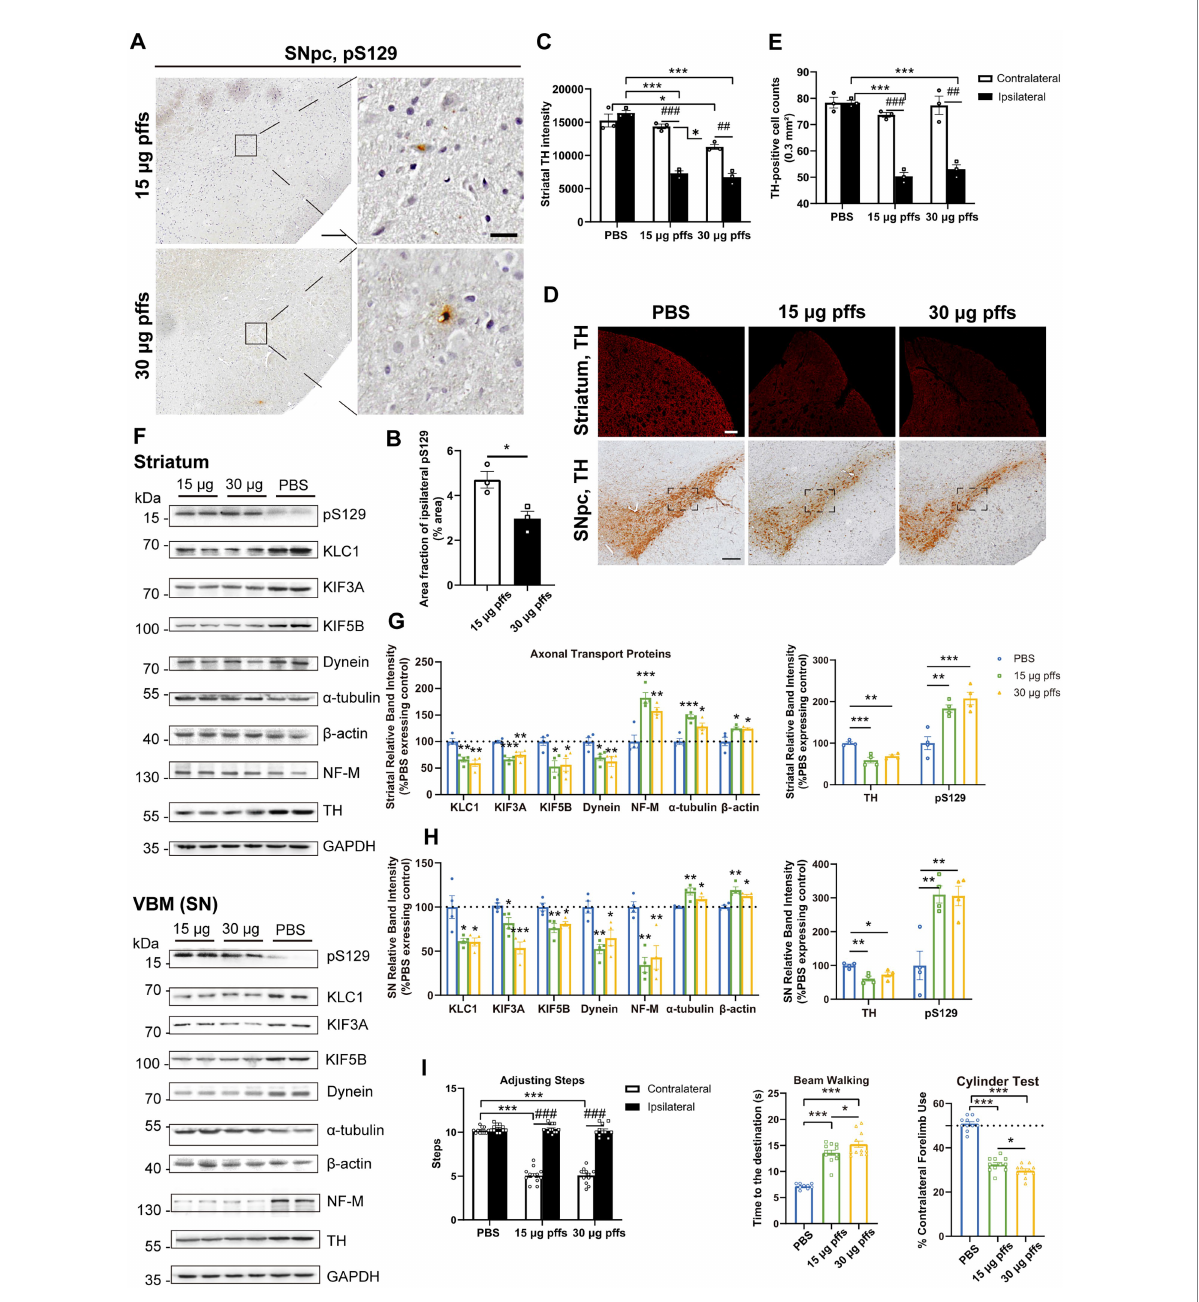
FIGURE 7 Evaluation of the nigrostriatal pathway at 6 months post injection. (A) α -Syn pS129 expression in the SNpc. Scale bar = 200 μ m (left) and 20 μ m (right). (B) The area fractions of the ipsilateral α -Syn pS129 in the SNpc were quantified by ImageJ ( n = 3; * p < 0.05). (C) Fluorescent densitometry of striatal TH ( n = 3; * p < 0.05, *** p < 0.001; ## p < 0.01, ### p < 0.001). (D) TH-positive cells in the nigrostriatal regions. Scale bar = 200 μ m. (E) TH-positive cells in the SNpc were quantified by counting ( n = 3; *** p < 0.001; ## p < 0.01, ### p < 0.001). (F) Representative western blot of nigrostriatal changes. (G,H) Quantitative analysis of the afore-mentioned proteins (* p < 0.05, ** p < 0.01, *** p < 0.001; n = 4). (I) Assessment of behavioral changes ( n = 11; * p < 0.05, *** p < 0.001; ### p < 0.001). All of the data was shown as means ±